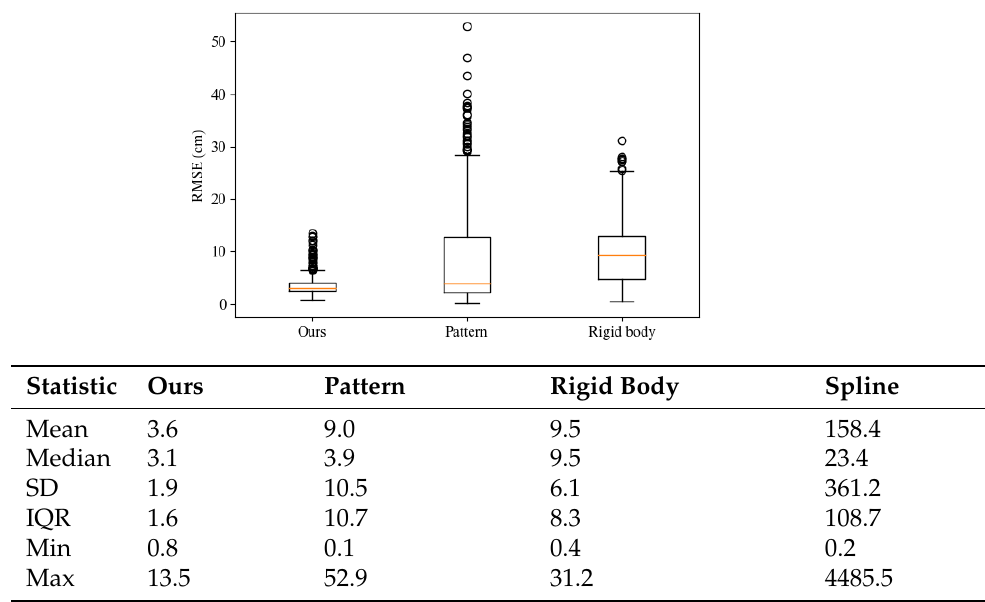
Table 4. Summary of the performance per method (RMSE values in cm).